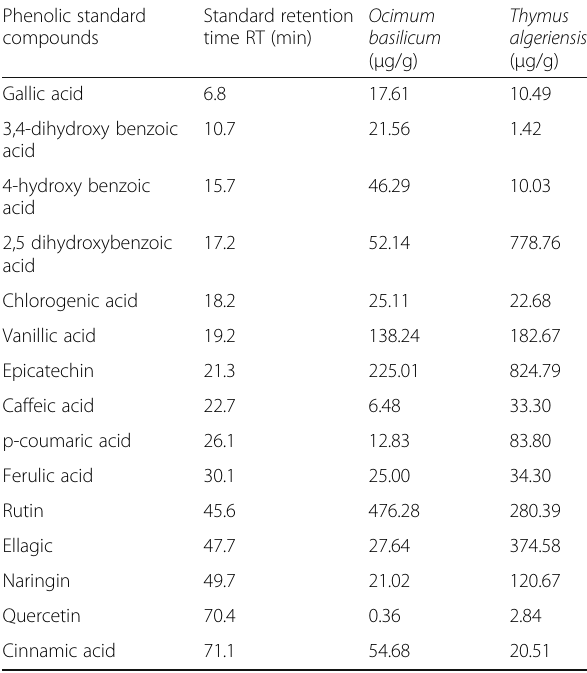
Table 2 HPLC analysis of ethanolic extracts for